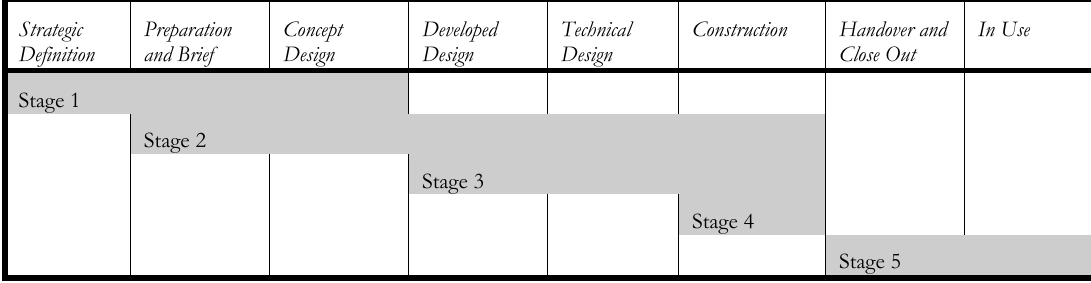
Table 1: Research stages mapped against the RIBA Plan of Work (RIBA, 2013)